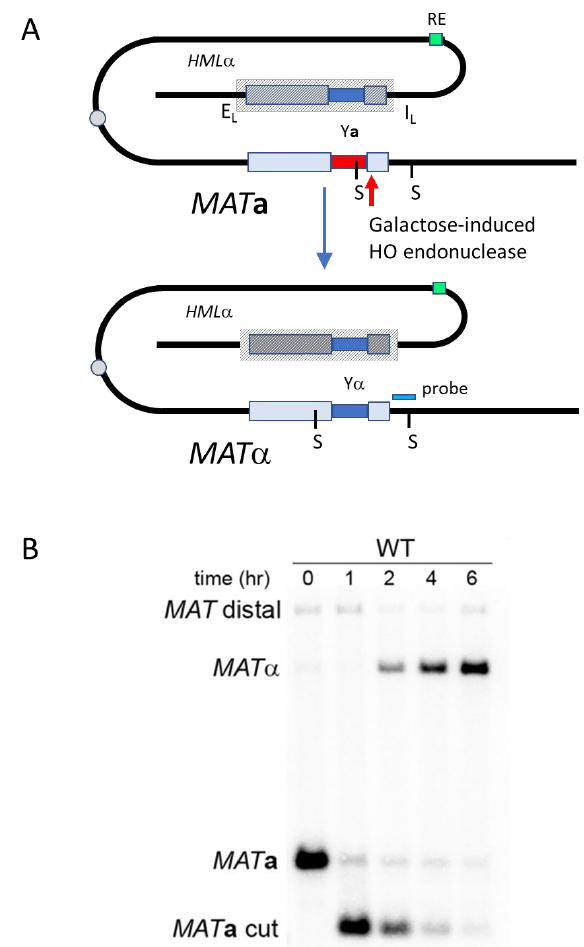
FIGURE 9: Mating-type gene switching in budding yeast. (A) Switching of MAT a to MAT  by homologous recombination be- tween the HO endonuclease-cleaved MAT a locus and the HML  donor locus. Part of chromosome III is shown. HML  and MAT a are each about 100 kb from the centromere (circle). HML  and the other donor, HMR a (not shown, at the opposite end of the same chromosome), are bounded by silencer sites (E and I) that create a highly ordered nucleosome structure (hatched lines) that makes the donors transcriptionally silent and prevents HO cleavage at the same  or a sequences that are present at MAT . A Recombination Enhancer (RE) facilitates the use of HML  through Fkh1 protein binding both to RE and to sites near the DSB. Sty I sites are indicated by S. (B) Kinetics of MAT switching. The cleavage of MAT a is com- plete after inducing HO endonuclease for 60 min. Cleavage and subsequent steps are assayed on a Southern blot, using a MAT - distal sequence as probe (green). HO-induced cleavage of MAT a is followed by the appearance of MAT  , which has different Sty I re- striction sites and is thus easily distinguished from MAT a . Here, the HML  donor also harbors a single-base pair mutation that prevents subsequent HO OPEN ACCESS | www.microbialcell.com 24 Microbial Cell | JANUARY 2019 | Vol. 6 No. 1